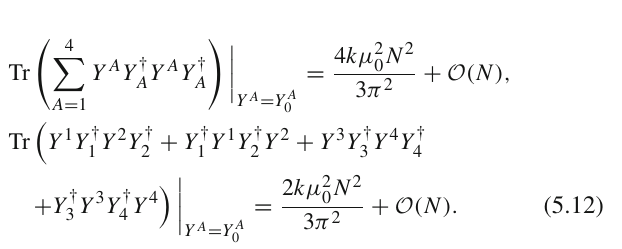
((cid:2) = 2 ) (cid:3) m (cid:2) O ((cid:2) = 2 ) (cid:3) HR